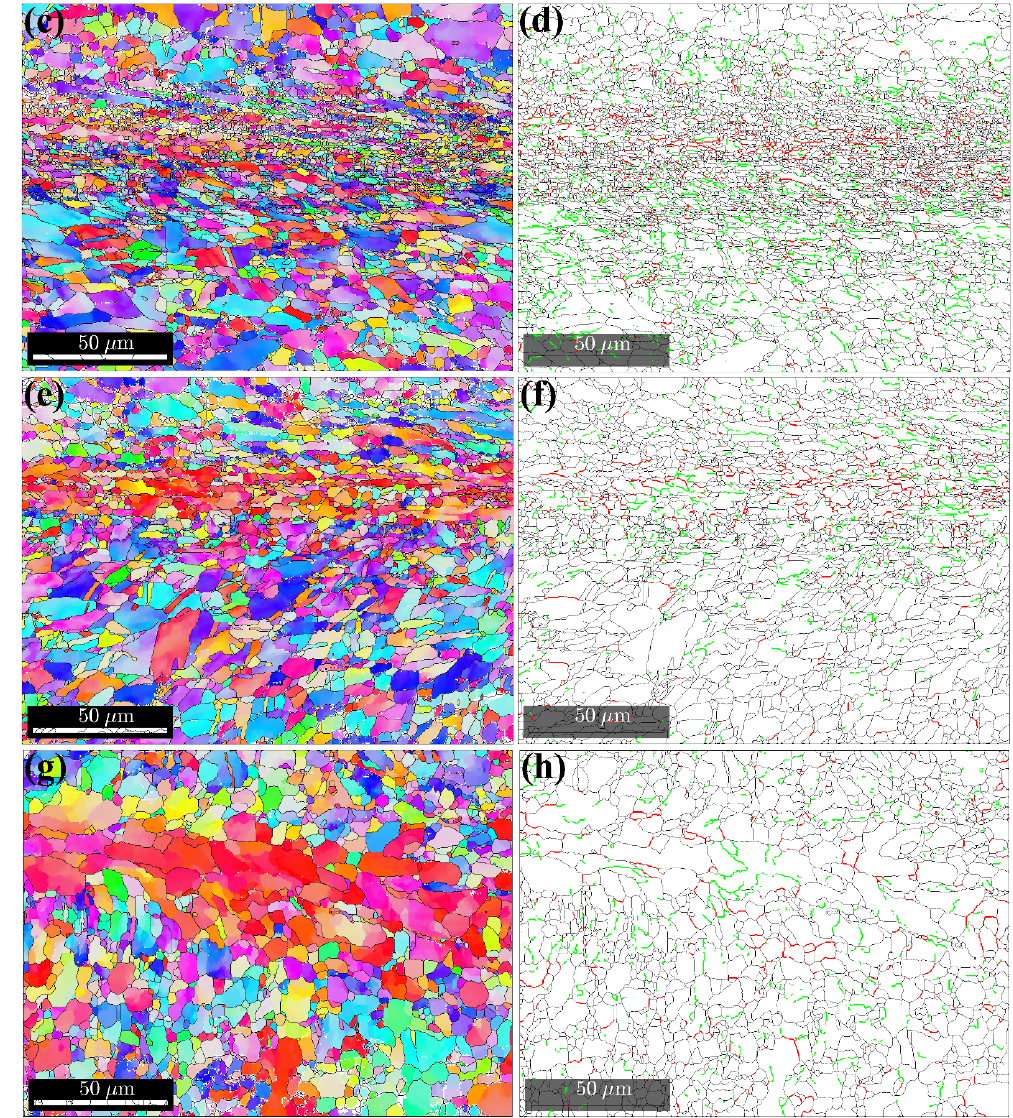
Figure 5. ( a , c , e , g ) EBSD orientation maps and ( b , d , f , h ) grain boundaries maps of ( a , b ) base metal and at the center of the weld zone for joints with weld energy of: ( c , d ) 800 J; ( e , f ) 1600 J and ( g , h ) 2400